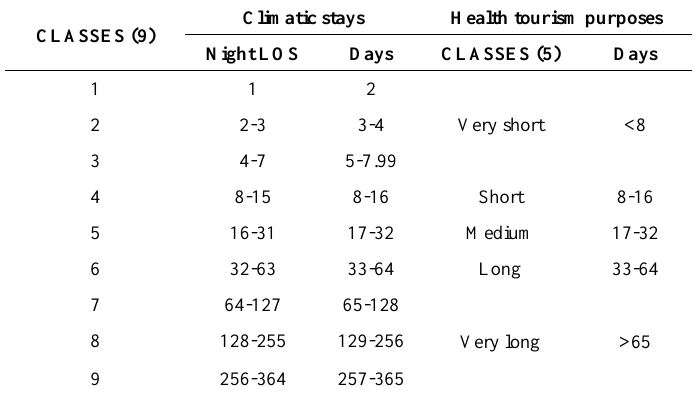
Table 2. Duration classes of climatic stays and stays for health tourism purposes. Interdisciplinary metrics